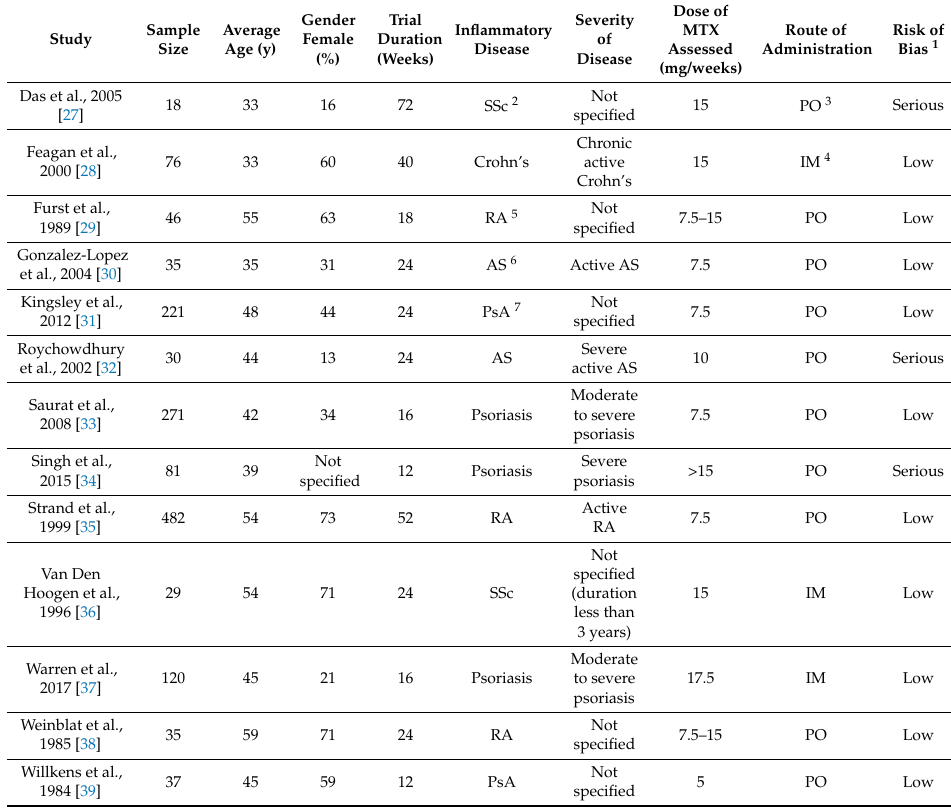
Table 1. Characteristics of included studies on the risk of infection from methotrexate therapy in inflammatory